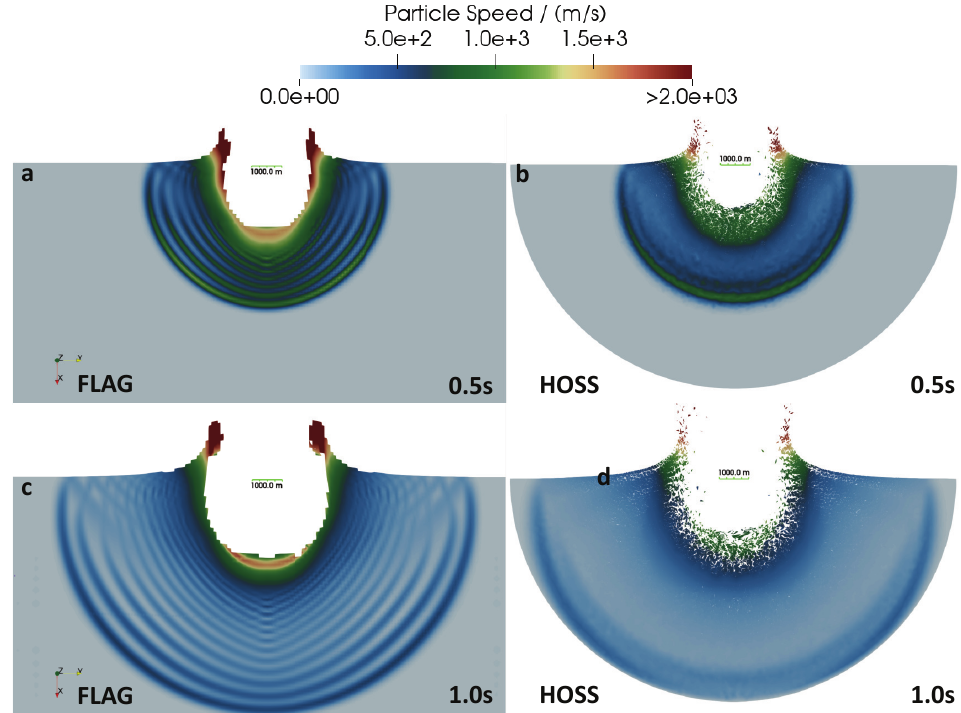
Figure 5. Particle velocity from a 2.0 × 10 4 m/s normal impact at 0.5 s ( a , b ) and 1.0 s ( c , d ) as calculated from 3D simulations from FLAG and HOSS. ( a , c ) show particle velocity from 3D FLAG simulations, and ( b , d ) show particle velocity from HOSS simulations. The length of the horizontal green bar shown inside the crater represents a distance of 1000